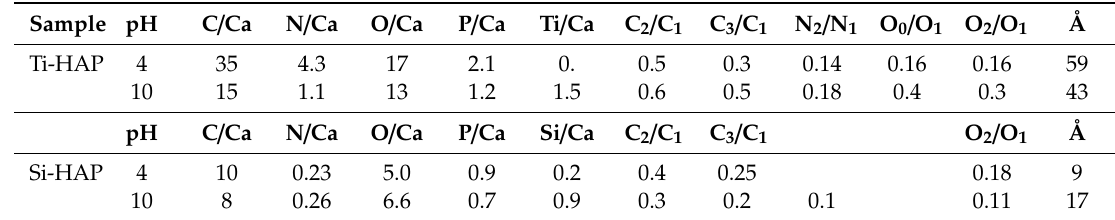
Table 4. Measured atomic ratios and overlayer thickness (Å) after samples incubation in SAP solutions at pH values of 4 and 10.